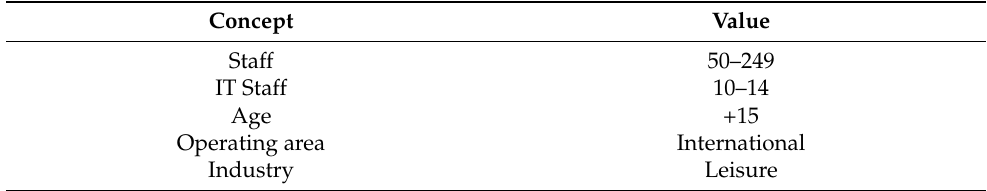
Table 2. Description of the company.